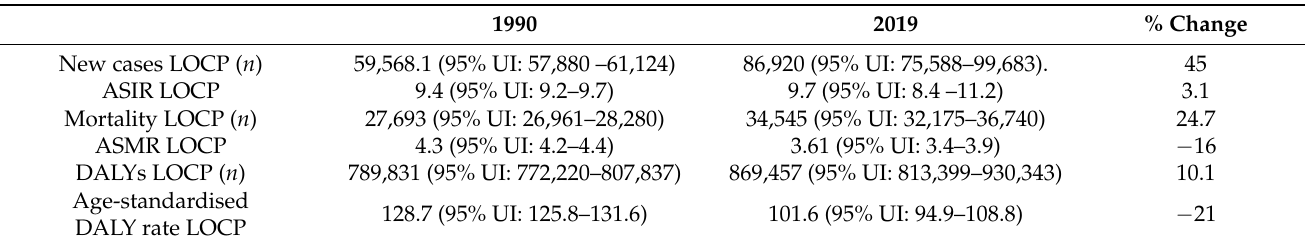
Table 1. Overall Trends of LOCP incidence, mortality rate and DALY in Europe, comparing 1990 and 2019.